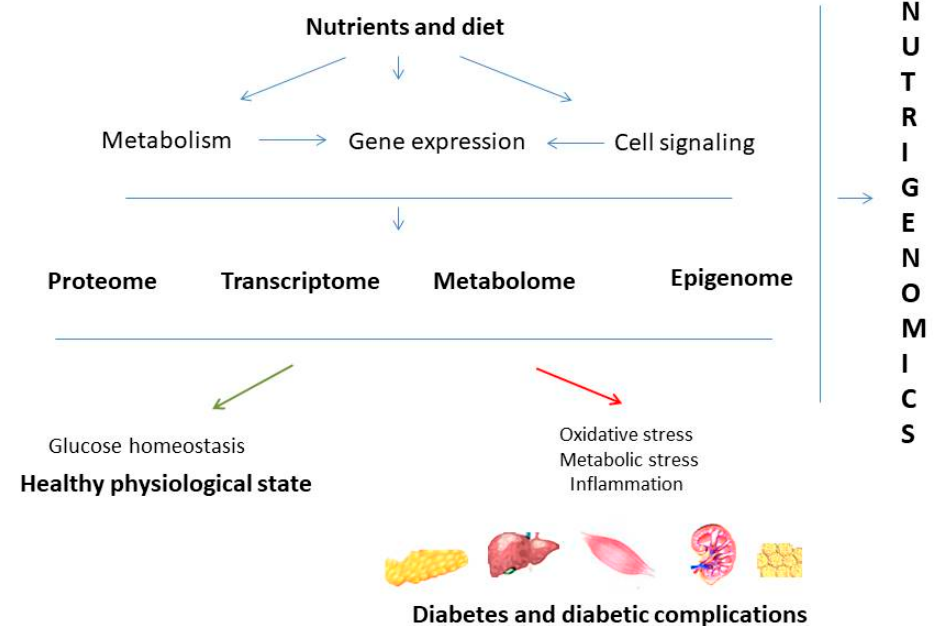
Figure 1. Concept of nutrigenomics in diabetes. Nutrients present in food can affect gene expression, cell signaling pathways, and cell metabolism. Those nutrient-gene interactions reflect on epigenome, transcriptome, proteome, and metabolome. Those interactions can be protective and lead to the healthy physiological state or can increase inflammation, oxidation, and metabolic stress which further lead to disturbed glucose homeostasis and progression to diabetes and diabetic complications.